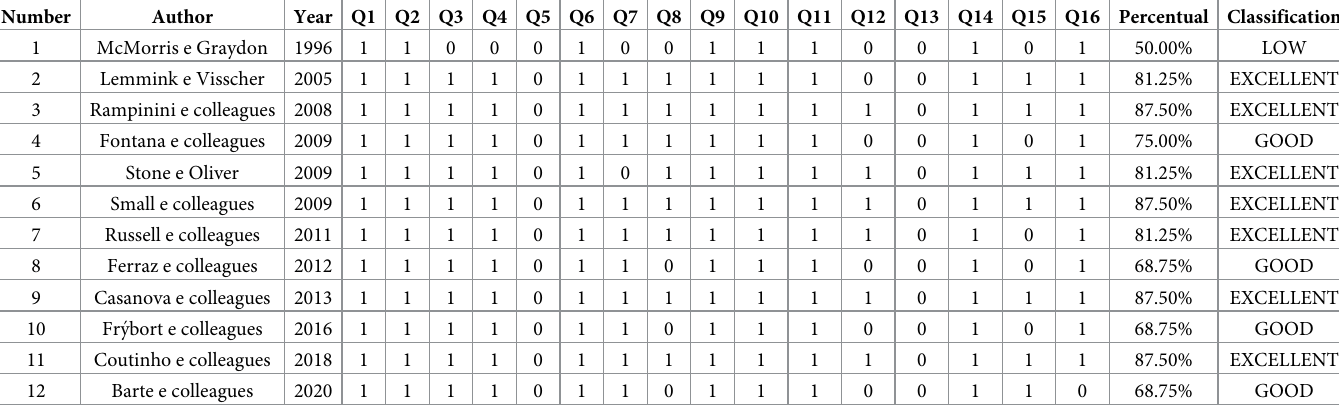
Table 4. Assessment of studies’ quality according to the pre-established methodological quality scoring